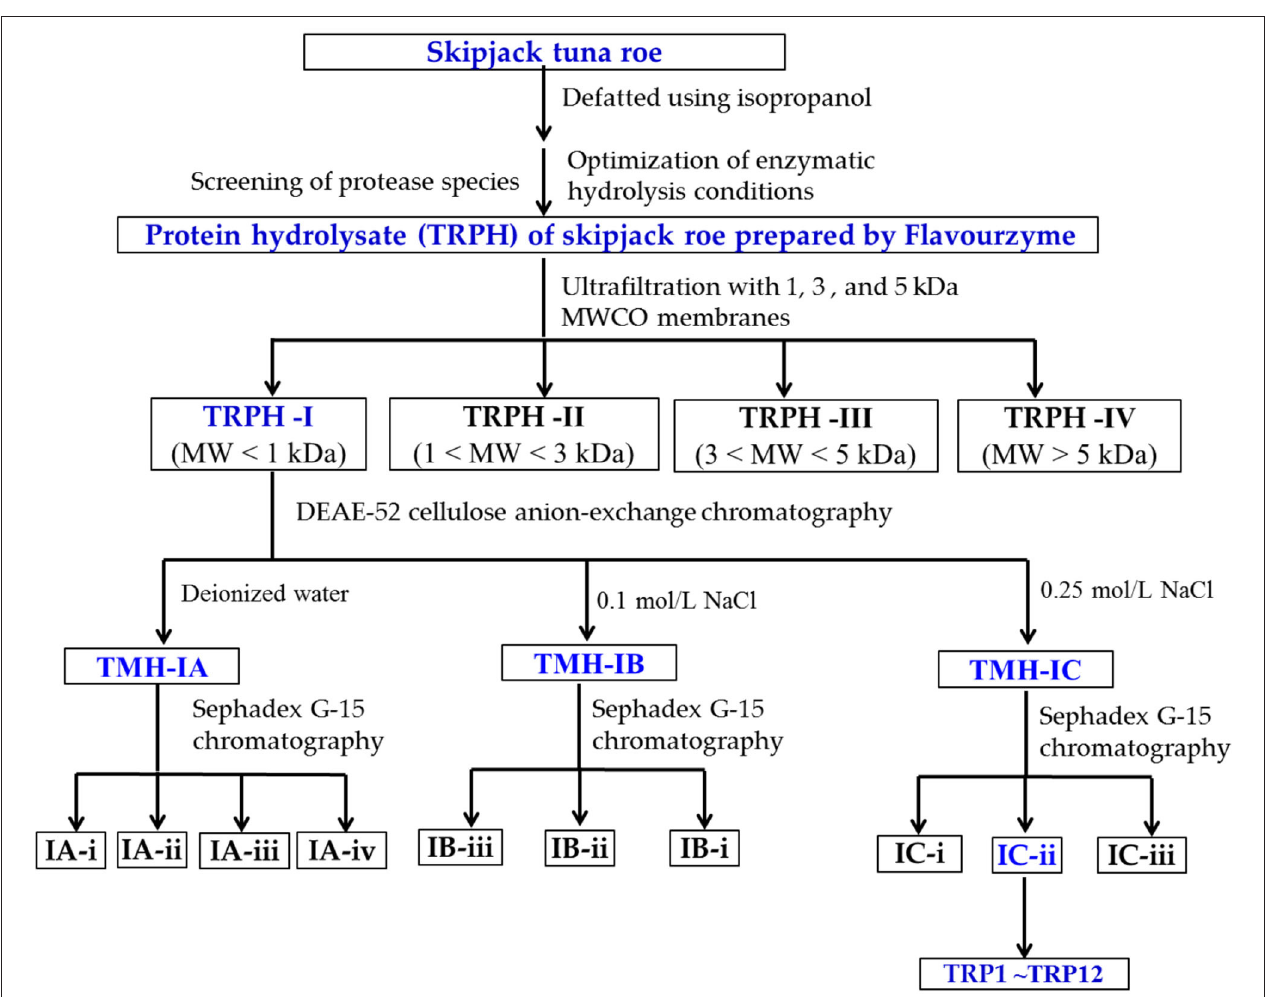
FIGURE 1 | Flow diagram of isolating antioxidant peptides (APs) from protein hydrolysate (TRPH) of skipjack tuna ( Katsuwonus pelamis ) roe prepared by